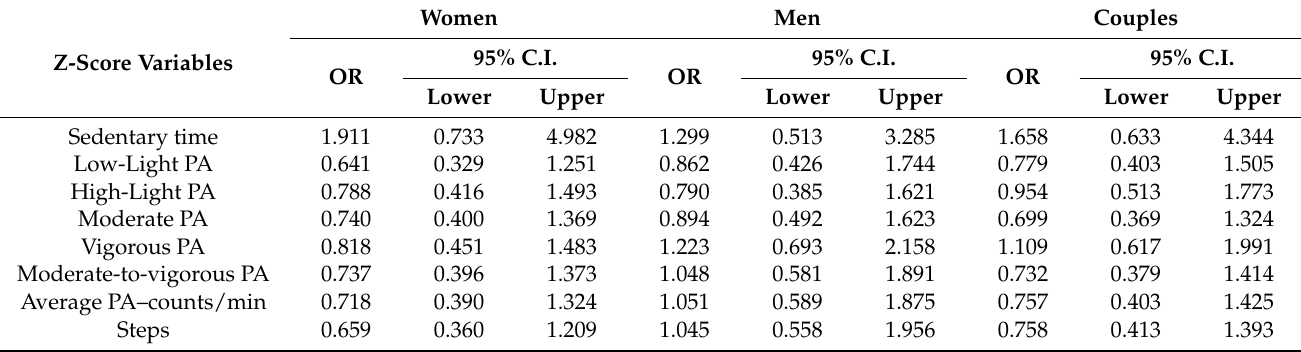
Figure 1. Physical and sedentary activity levels (expressed as z-scores, means and 95% confidence intervals) of the couples (accumulated time, i.e., sum) in those who needed invasive assisted reproductive techniques (IVF and ICSI) compared with those couples that became spontaneously pregnant. * Sedentary time score is interpreted opposite to the rest of the activity indicators. Differences between groups were analyzed by ANCOVA adjusting for couple age (sum of the woman and man ages) and accelerometer-registration time (sum of the woman’s and man’s registered time). PA–Physical activity, MVPA–Moderate to Vigorous PA, CPM–counts per minute. Table 3. Likelihood of having a baby according to time spent in sedentary time and physical activity in women, men and the accumulated (sum) activity level of the